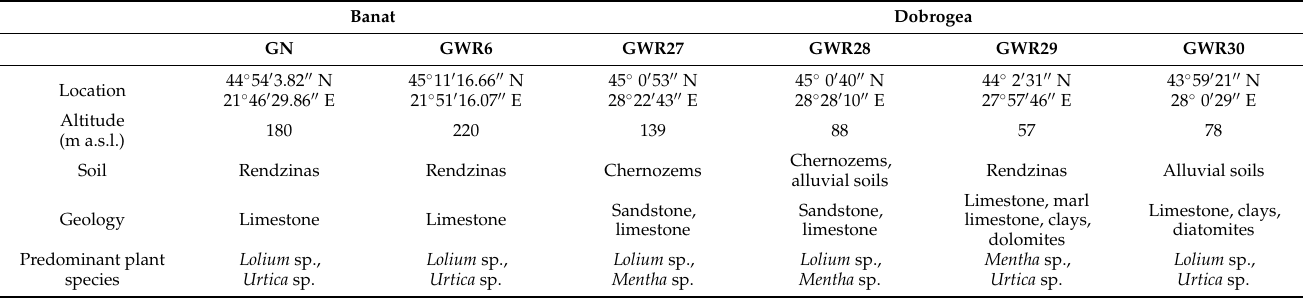
Table 1. Geology and geographic settings of studied